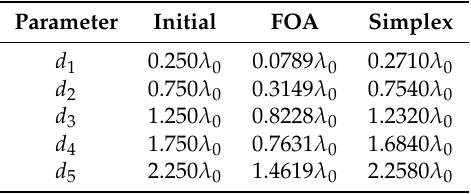
Table 2. Element positions of the second array factor synthesis